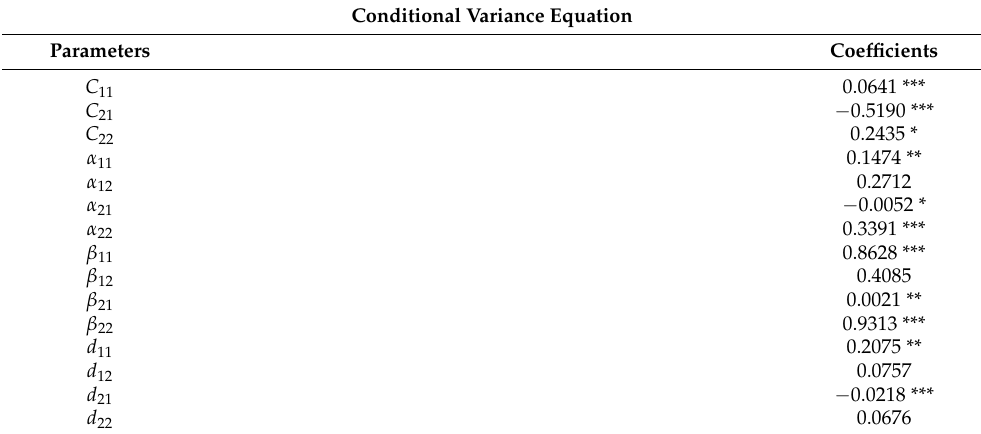
Table 6. Volatility spillover between the bond and yen-funded carry trade (rCT/yen)